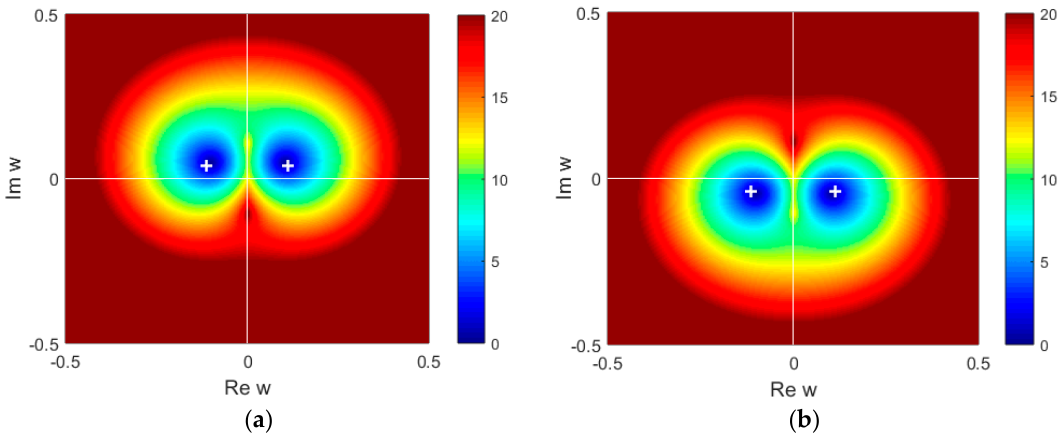
Figure 2. Roots of the functional Equation (35), corresponding to the: upper ( a ); and lower ( b ) signs in the right-hand side, for x = 4 m, ε 0 = 81, ε 1 = 9, z 0 = 2 m, z 1 = 6